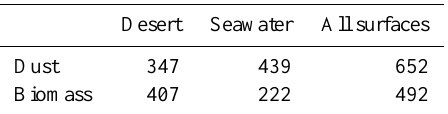
Table 3. Number of selected channels for 75% total IC on aerosol parameters.